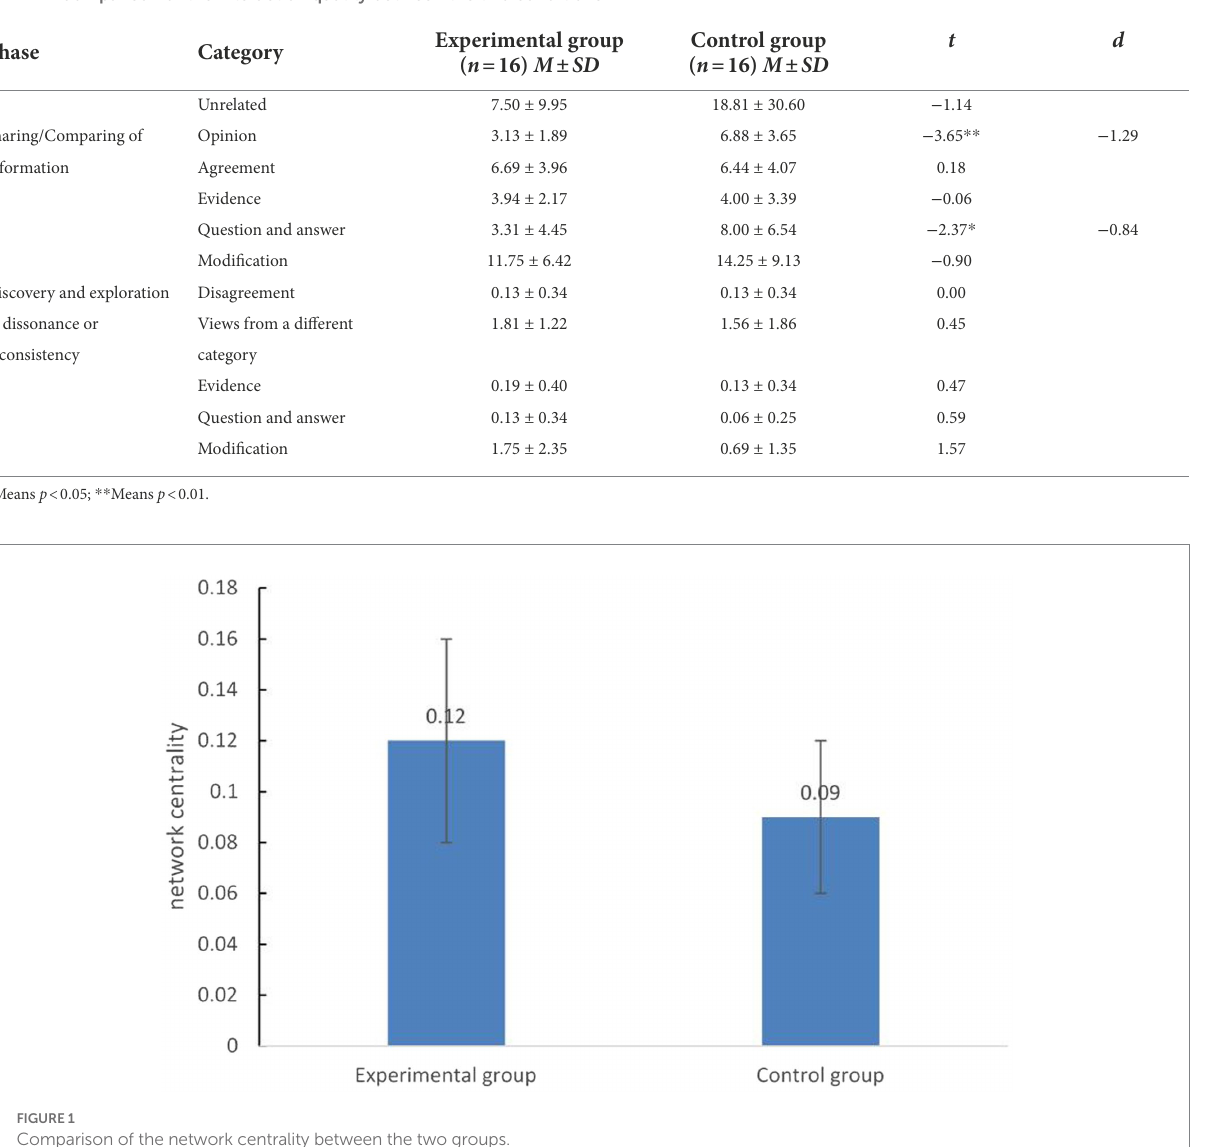
TABLE 2 Comparison of the interaction quality between the two conditions.